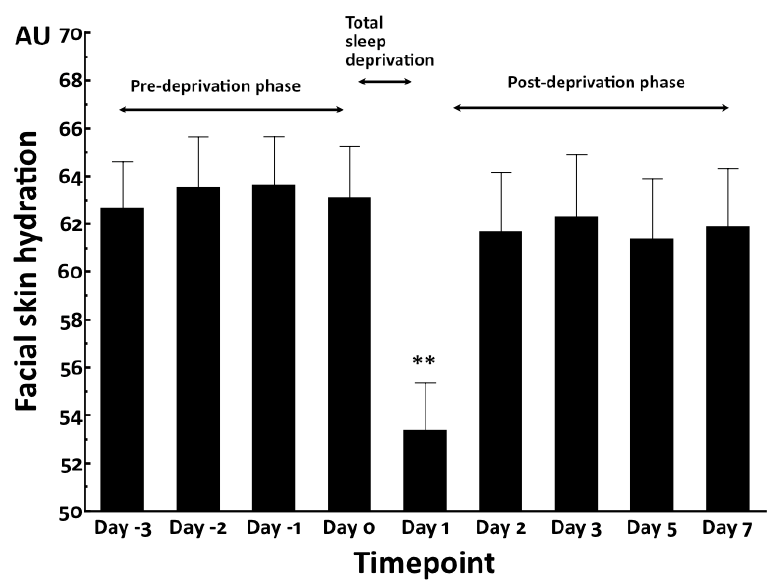
Figure 2. Facial skin hydration in total sleep deprivation study. **: p < 0.01 compared to Day 0.